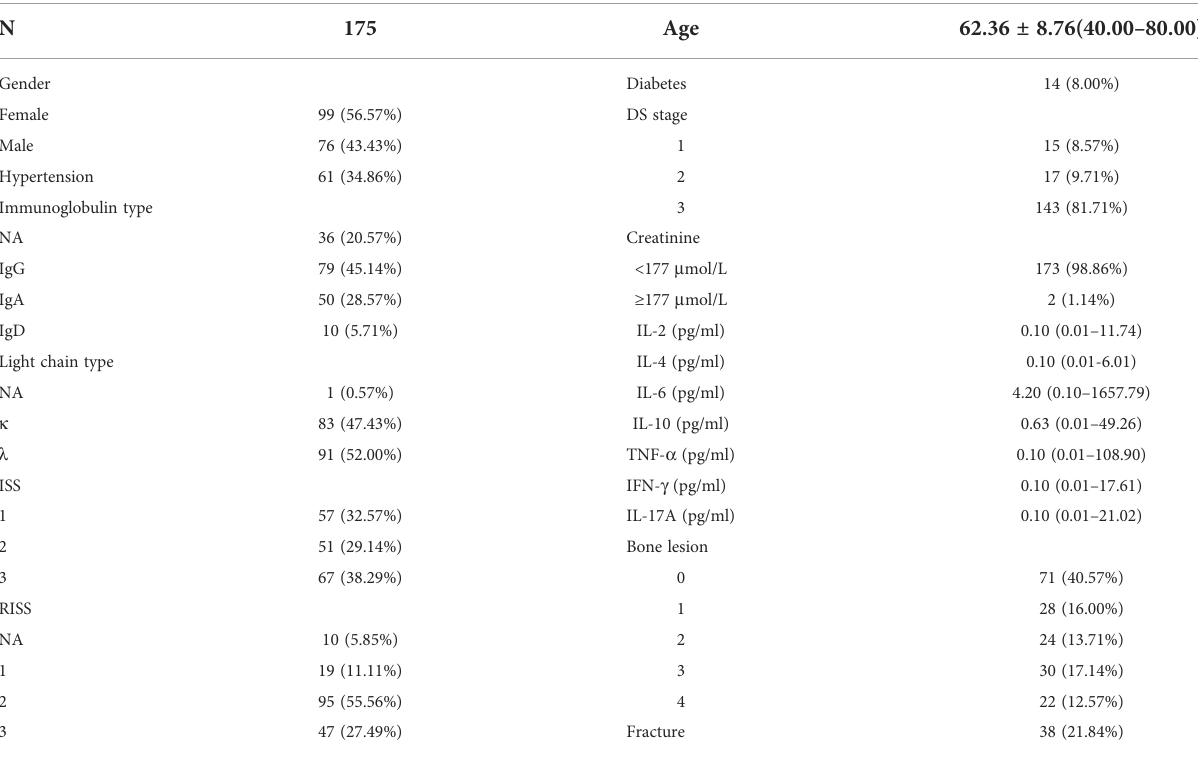
TABLE 1 Demographics of patients with MM.